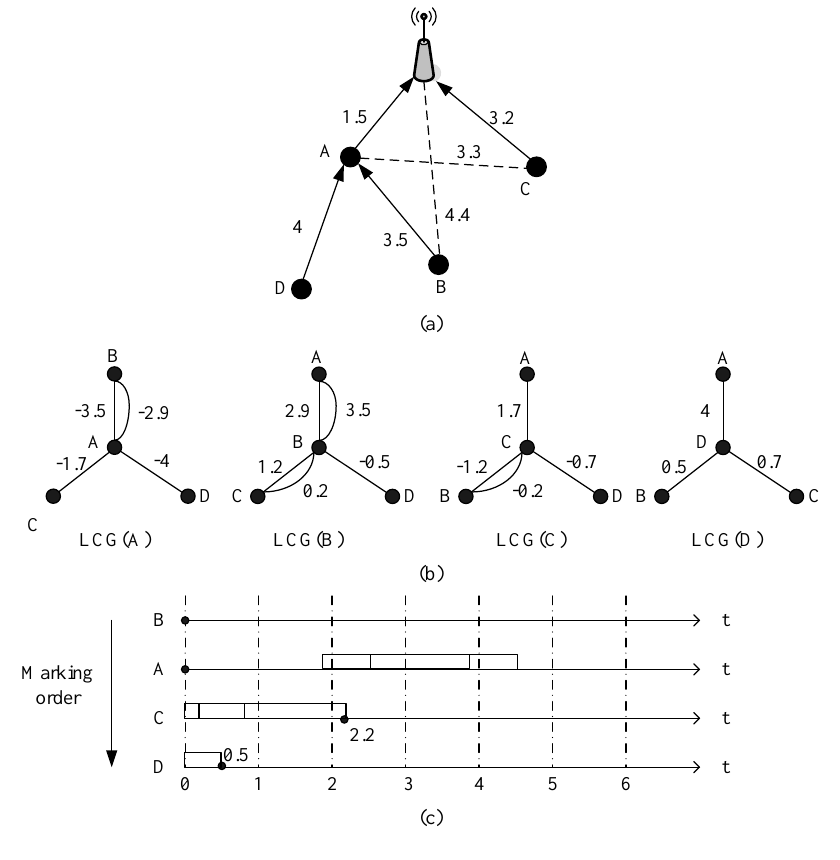
Figure 5. ECS process: (a) network topology; (b) nodes‟ LCG; (c) marking order and